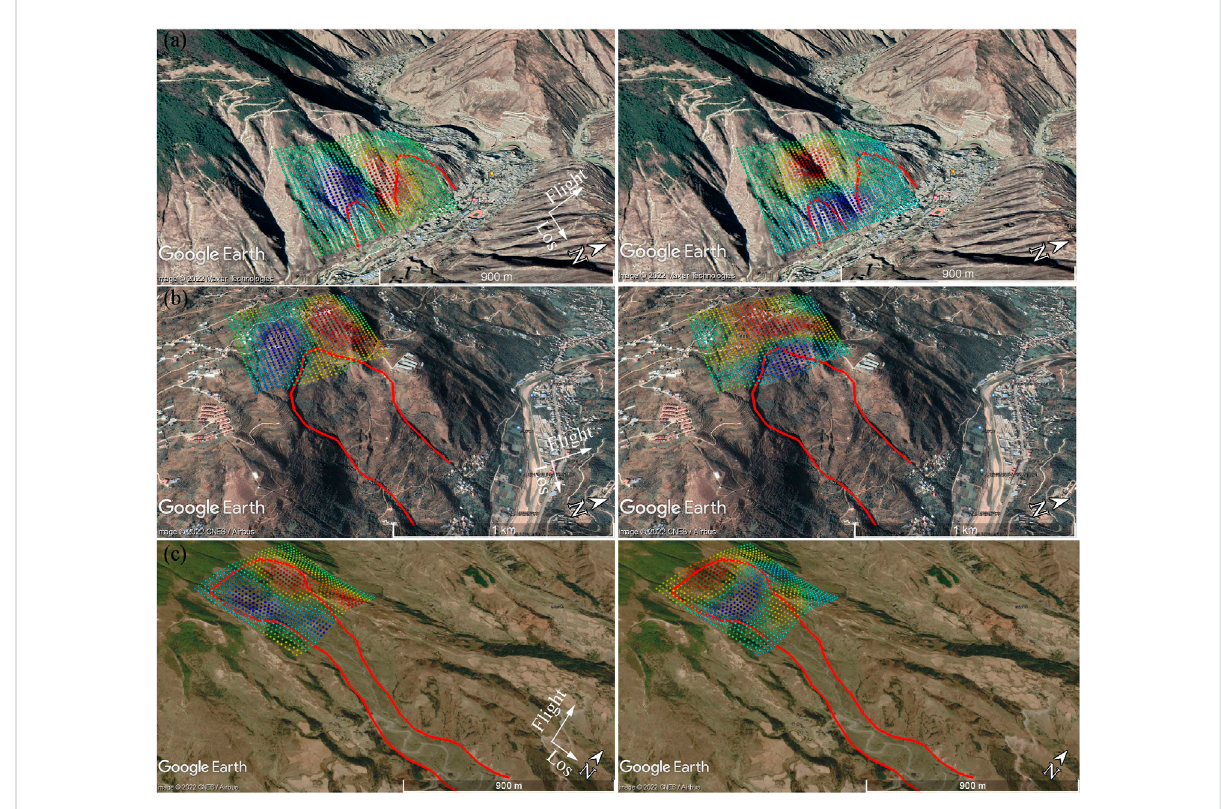
FIGURE 8 Veri fi cation of three slow-moving landslides detected from phase-gradient stacking in the azimuth (left column) and range (right column) directionsandsuperimposedonGoogleEarth.Thegradientsarescaledto[ − 4,4]radiansasshowninFigure6.Theredpolygonsdepictboundariesof these landslides identi fi ed from optical images based on their geomorphological